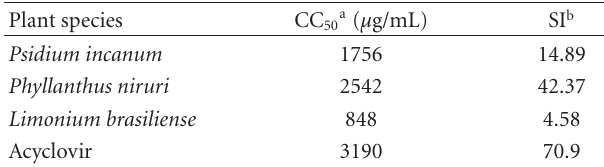
Table 2: CC 50 and SI calculated for each anti-HSV-1